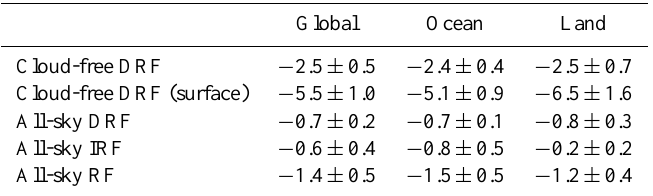
Fig. 5. Seasonal distributions of shortwave aerosol forcing at the top of the atmosphere, in Wm − 2 , as derived from the MACC re-analysis over 2003–2010. From top to bottom, clear-sky (or cloud-free) direct forcing, all-sky direct forcing, all-sky first indirect forcing, and the sum of all-sky direct and first indirect forcing. First indirect forcing is not estimated poleward of 60 ◦ latitude. Global averages are given by the numbers below each panel. Table 3. Anthropogenic aerosol direct radiative forcing (DRF) in cloud-free and all-sky conditions, and first indirect radiative forcing (IRF) and total aerosol radiative forcing (RF) in all-sky conditions, as derived from the MACC re-analysis over 2003–2010. All values are in Wm − 2 at the top of the atmosphere (TOA), unless where stated, for the shortwave spectrum only. See Sect. 7 for calculations of uncertainties. Values are global for the DRF, but for 60 ◦ N–60 ◦ S for the IRF and